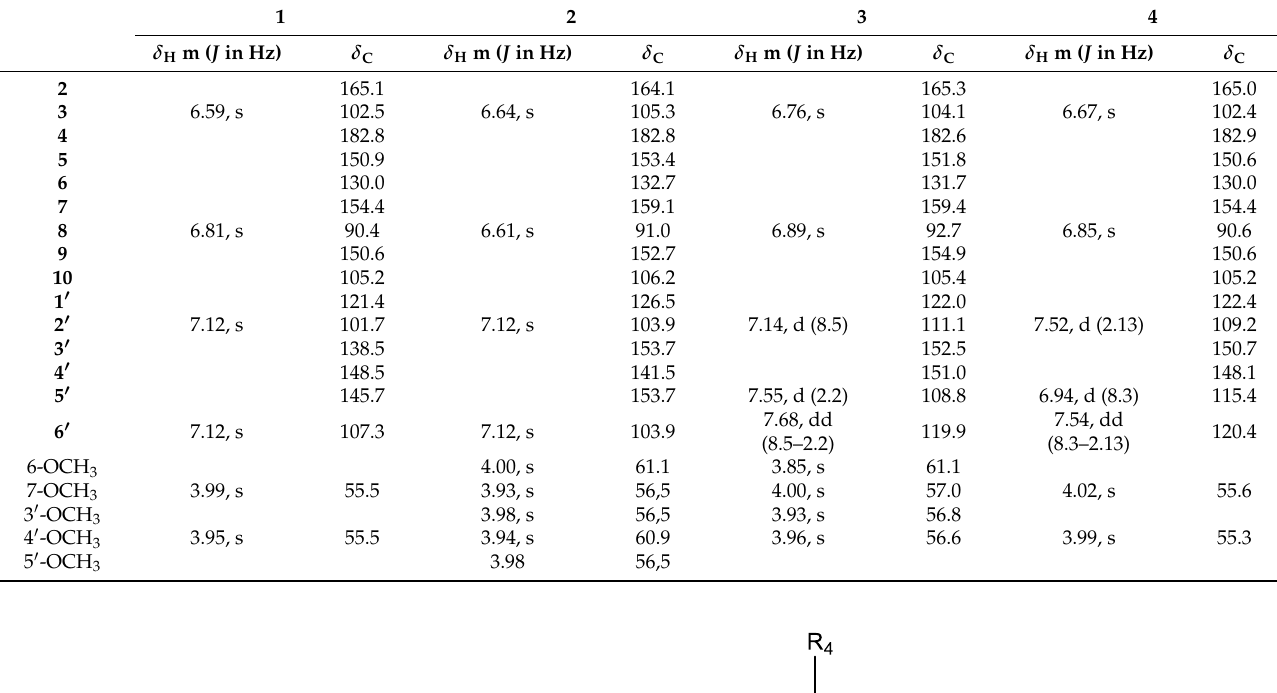
Compound 2 , a white amorphous powder, possessed a molecular formula of C 20 H 20 O 8 based on the protonated ion peak at m / z 388.9 by LC/MS, indicating seven degrees of unsaturation. The 1 H-NMR (proton nuclear magnetic resonance) (Table 4) displayed resonances for three singlets at δ H 7.12, 6.64, and 6.61 ppm, suggesting aromatic ring hydrogens, and five singlets between δ H 3.8 and 4.1 ppm, integrating for the three protons characteristic of a methoxy group. The 13 C-NMR (carbon-13 nuclear magnetic resonance, J-modulated) data exhibited in total 20 carbon resonances attributed to one ketone carbonyl Table 4. 1 H and 13 C NMR spectroscopic data for compounds 1-4 (500 MHz, MeOD). carbon ( δ C 182.8), 11 quaternary carbons (singlet, δ C 165–106), four carbons (doublets, δ δ C 105–90) suggesting C-H bonds and five carbons (singlet, C 56–62) characteristic of carbons linked to a methoxy group. Thus, the structure of compound 1 was established as 5-hydroxy-6,7,3 (cid:48) ,4 (cid:48) ,5 (cid:48) -pentamethoxyflavone (Figure 4). This result was compared to [58]. Table 4. 1 H and 13 C-NMR spectroscopic data for compounds 1–4 (500 MHz, MeOD).